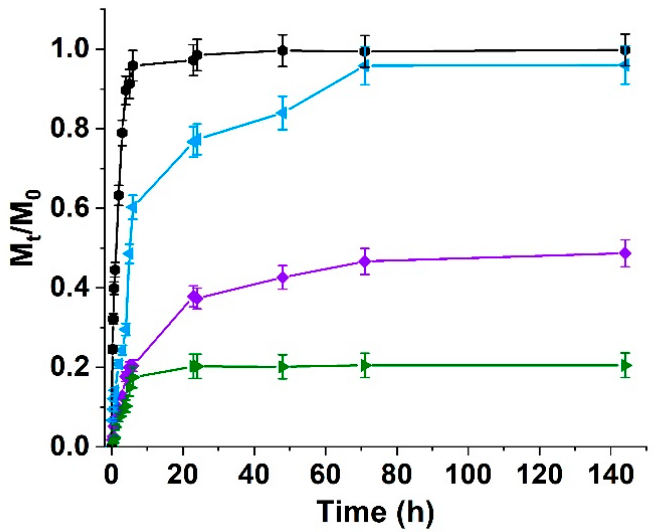
Figure 6. CUR release from H A − GO at 0 (purple line), 12 (cyan line), 24 (green line), and 48 (black line) V.